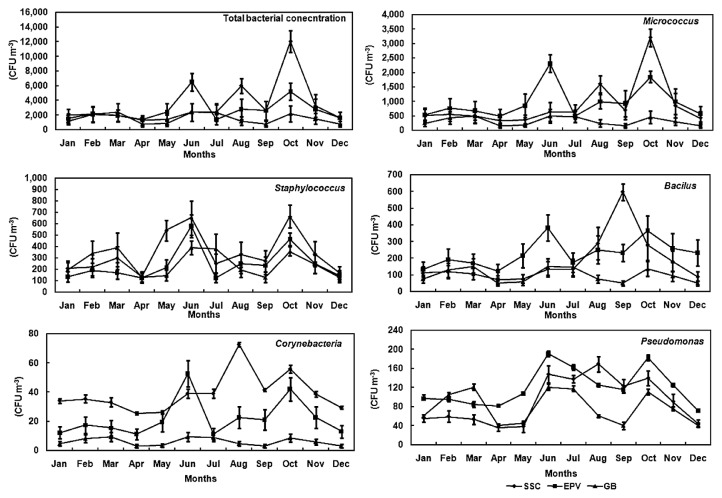
Monthly variation pattern of the airborne concentration of culturable bacteria at the three sampling sites.